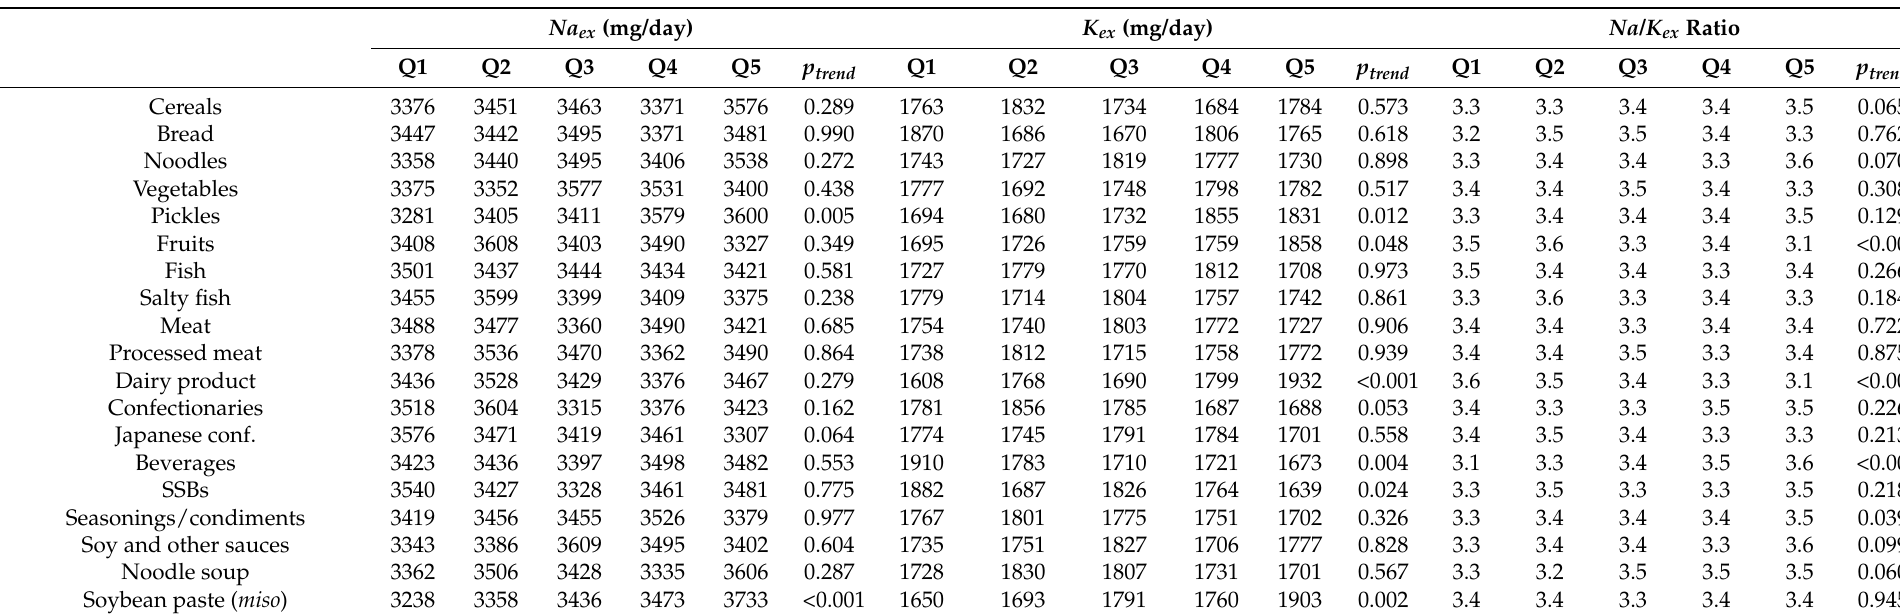
Table 4. Least square means of minerals estimated from overnight urine (g/day) across quintile strata of food